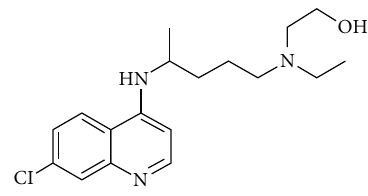
Figure 6: Molecular graph of